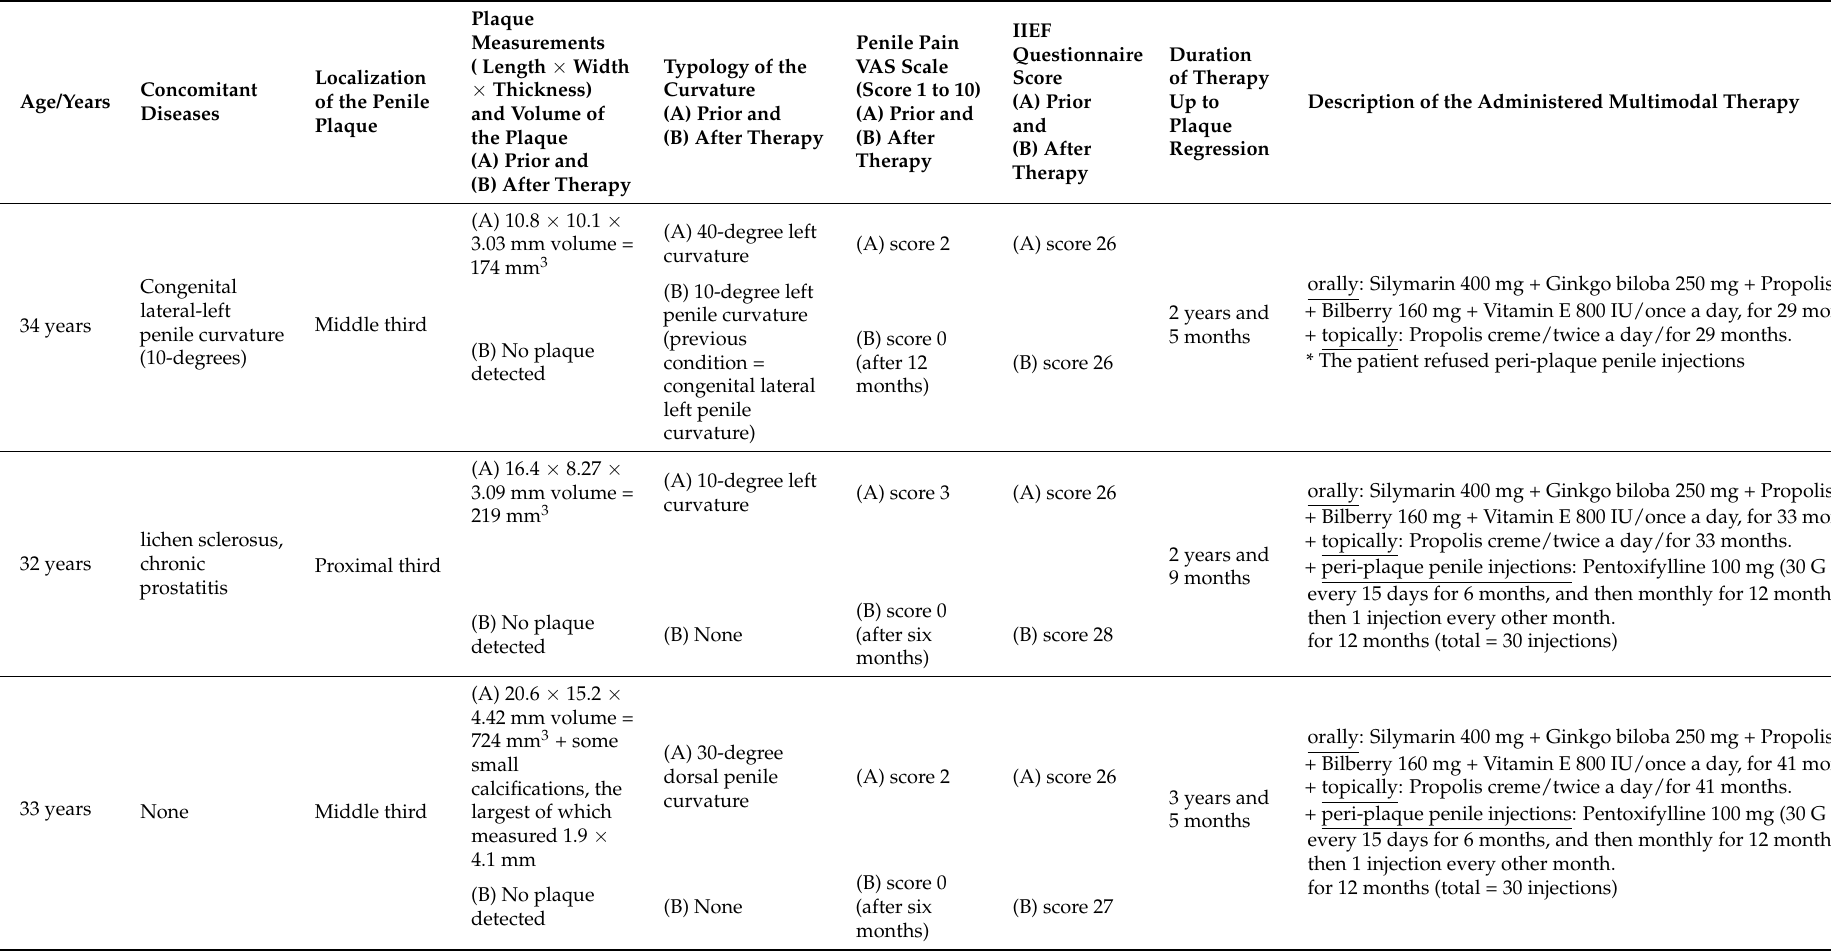
Table 1. Summary of the 3 cases of patients with Peyronie’s disease who were treated with multimodal antioxidant